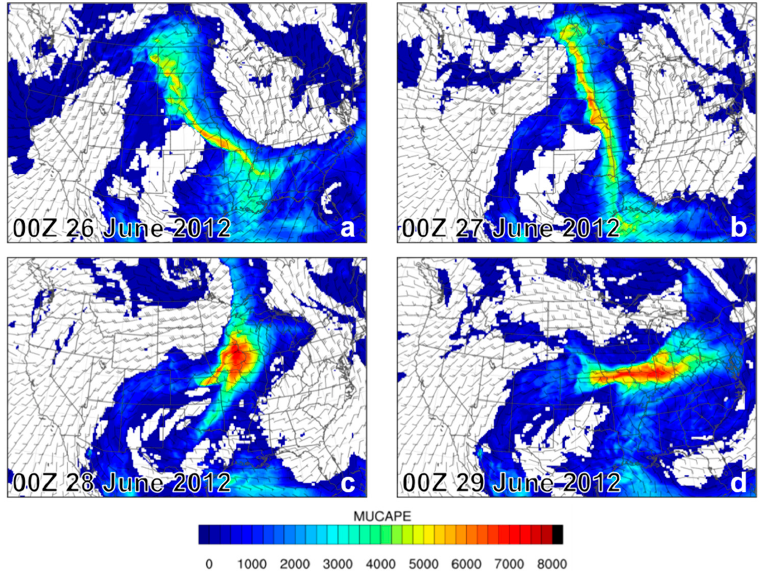
Figure 15. WRF-ARW 18 km simulated maximum CAPE (MUCAPE, J kg − 1 ) and mean layer wind barbs (kts) (calculated between 0–3000 m AGL) for ( a ) 00Z 26 June, ( b ) 00Z 27 June, ( c ) 00Z 28 June, and ( d ) 00Z 29 June 2012.